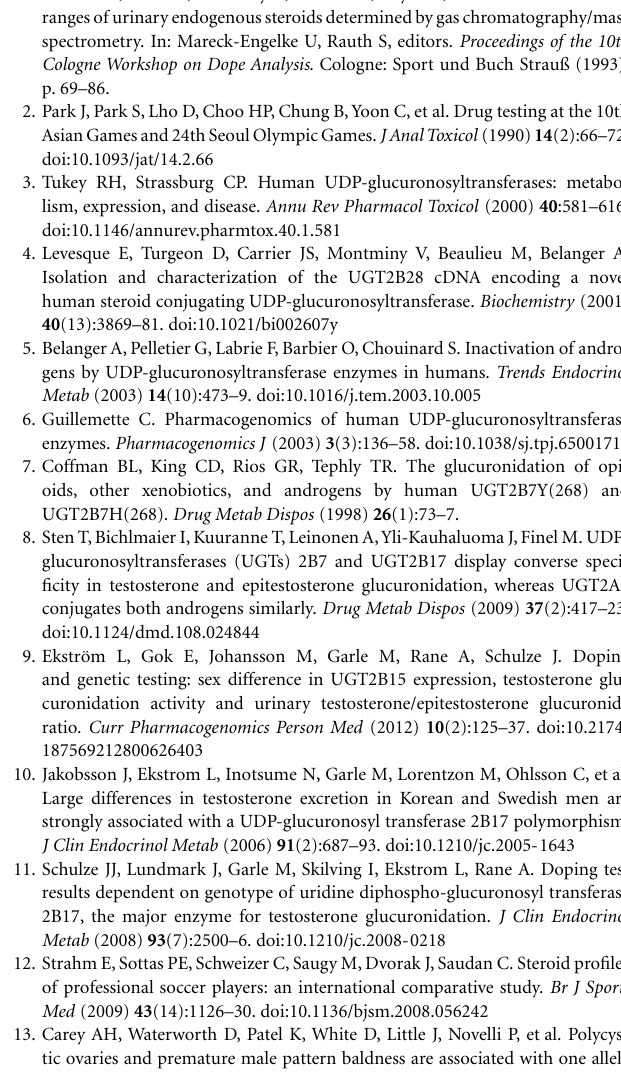
androstanediol glucuronides in serum (25). We were unable to find any associations with this polymorphism and urinary steroid levels ( Table 1 ). The impact of genetic polymorphisms on the steroid profile must be carefully interpreted since the study group is small and the variation caused by the menstrual cycle in the non-HC-users is